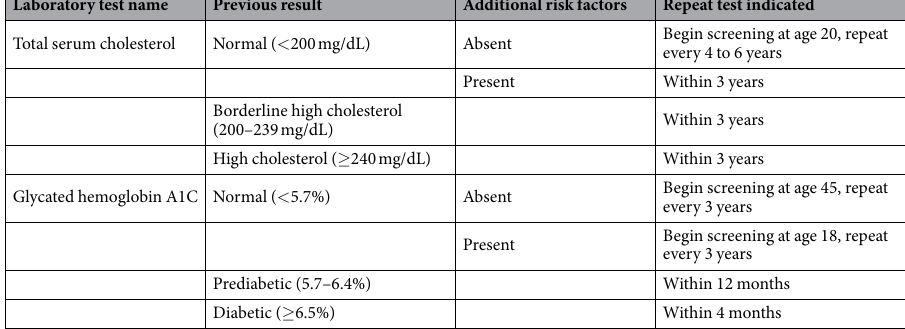
Table 1. Guidelines for performing screening and monitoring tests 18, 19 . Additional patient risk factors include hypertension, obesity, smoking, and family history of premature disease in a first-degree